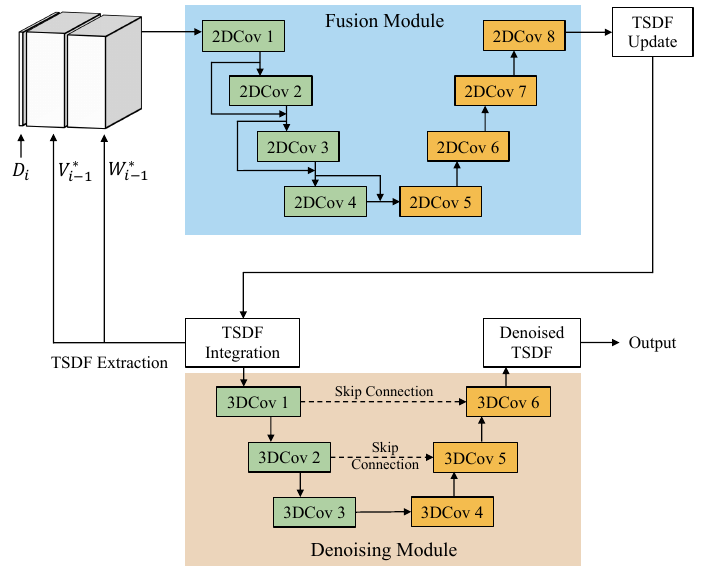
Figure 3. The DFusion